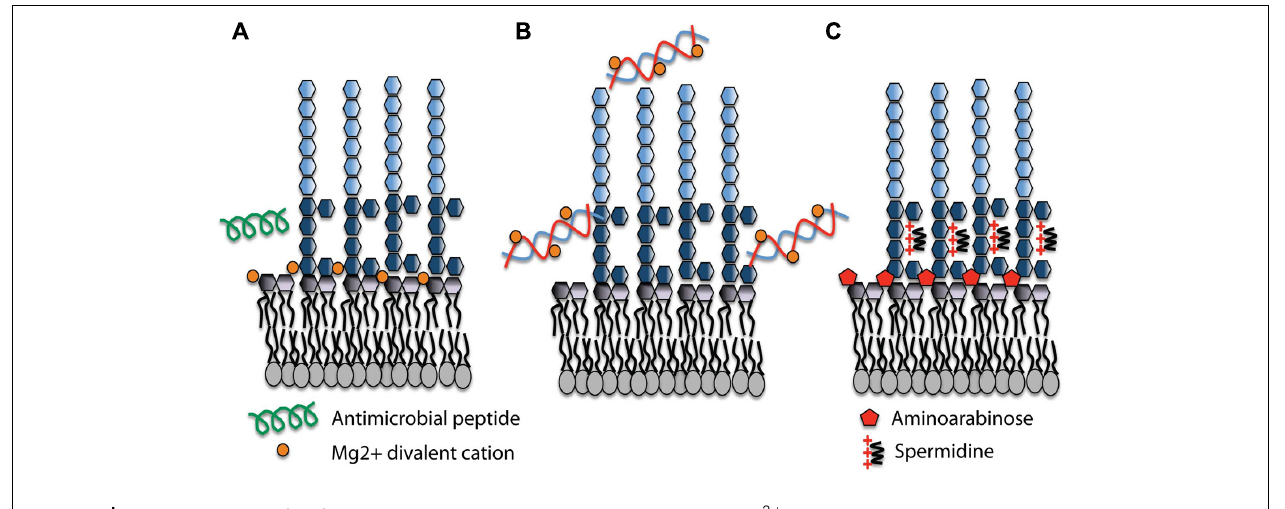
FIGURE 1 | Lipopolysaccharide (LPS) modifications in the presence of extracellular DNA that contribute to antimicrobial peptide resistance. (A) Divalent metal cations including Mg 2 + (orange) bind to the negatively charged phosphates of the lipid A moiety of LPS and act to stabilize LPS. Antimicrobial peptides (green) can displace cations and disrupt membrane integrity, leading to cell lysis and death. (B) Extracellular DNA binds and sequesters cations from the environment and the membrane. (C) In response